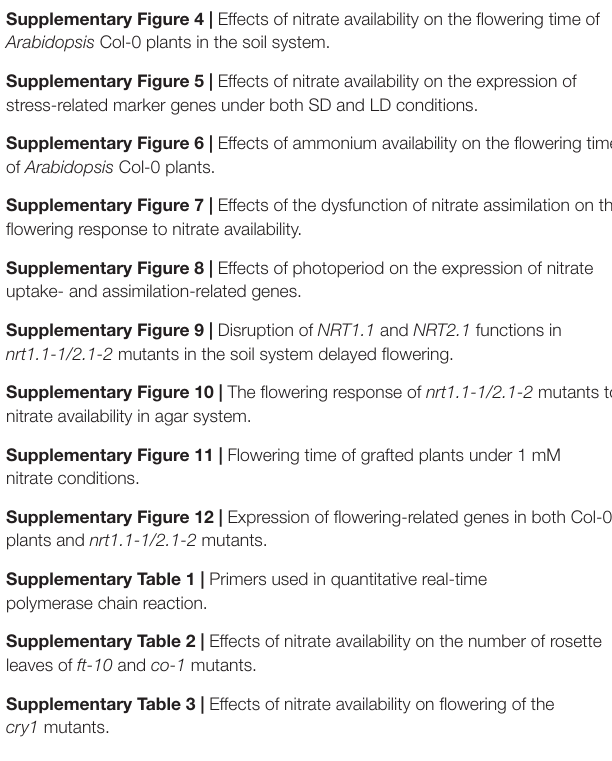
Supplementary Figure 2 | Effects of nitrate availability on the growth of Arabidopsis Col-0 plants.